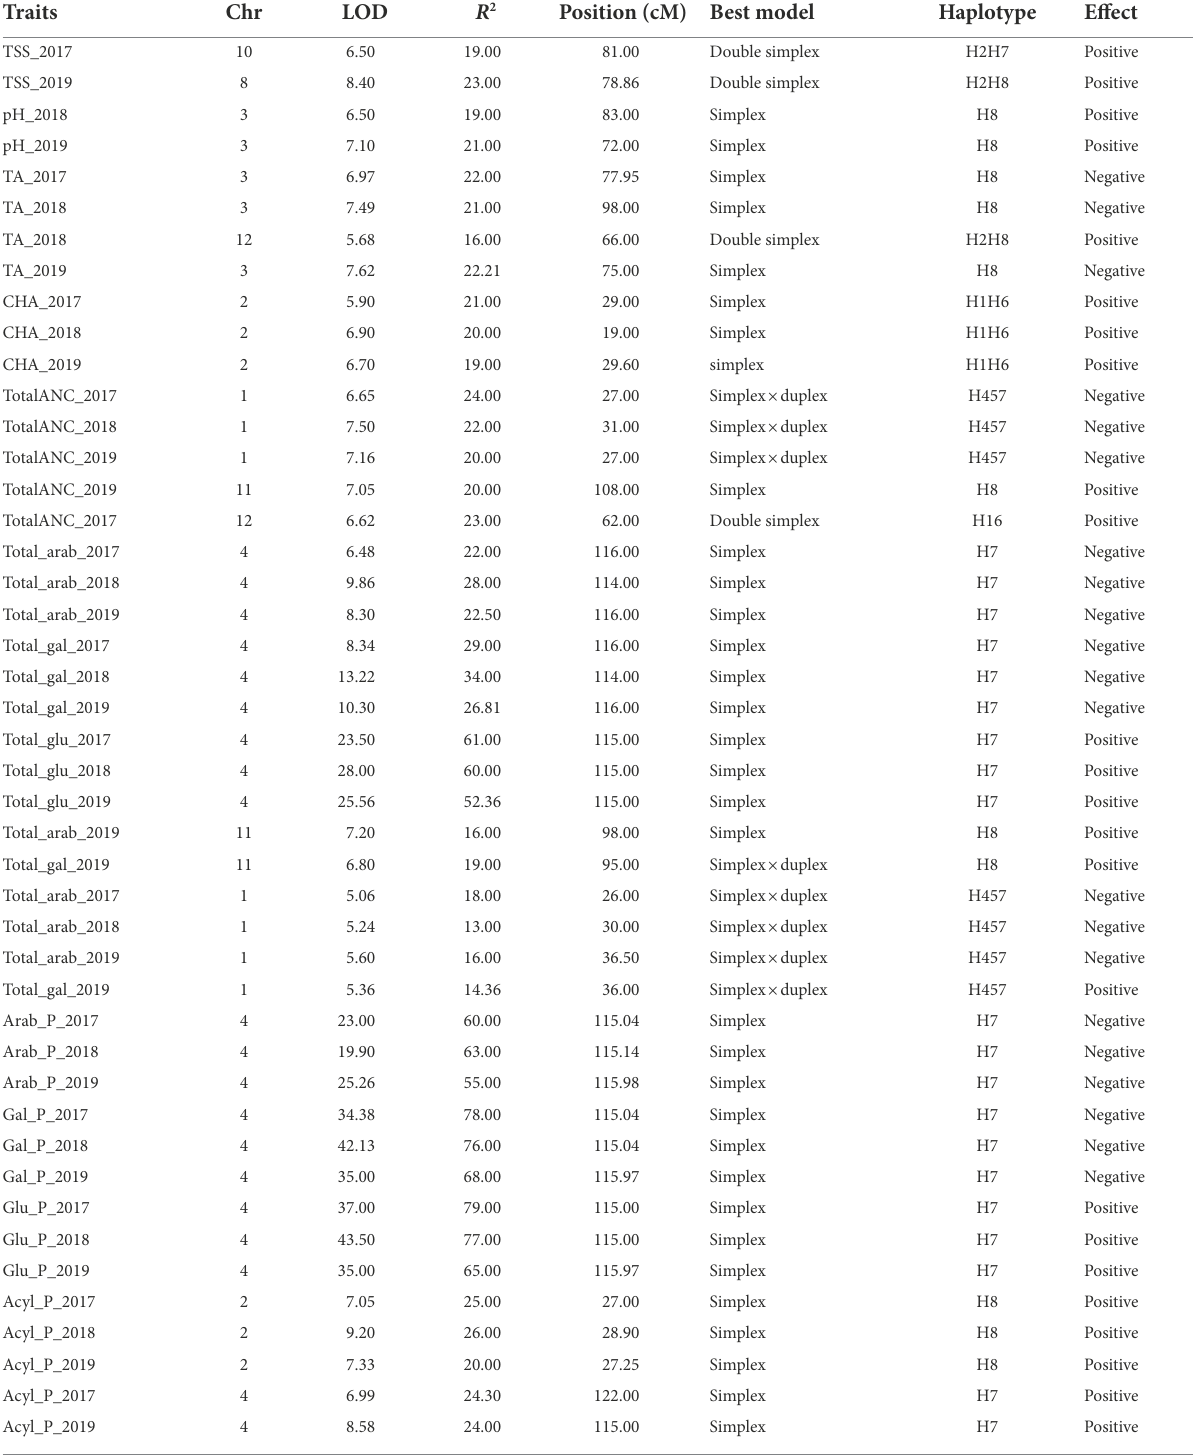
TABLE 1 Summary of quantitative trait loci for FQ traits (TSS, TA and pH) anthocyanins concentration and anthocyanin composition detected in the DSxJ mapping population. Traits Chr LOD R 2 Position (cM) Best model Haplotype